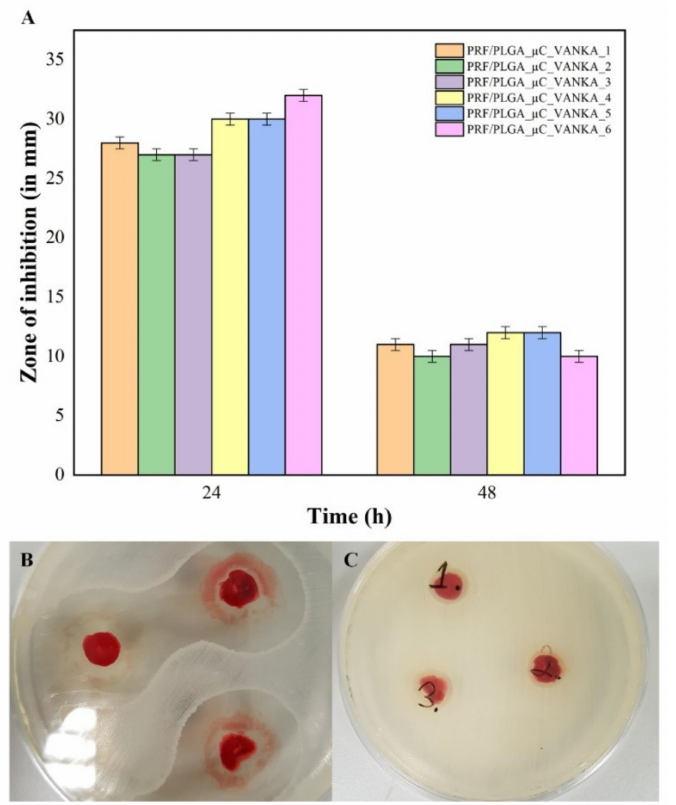
Figure 12. Antibacterial properties of PRF/PLGA_ µ C_VANKA samples: ( A ) inhibition zones in mm; ( B ) sterile areas around the PRF/PLGA_ µ C_VANKA samples after 24 h incubation; ( C ) sterile areas around the PRF/PLGA_ µ C_VANKA samples after 48 h incubation. The diameter of the petri dishes is 8.5